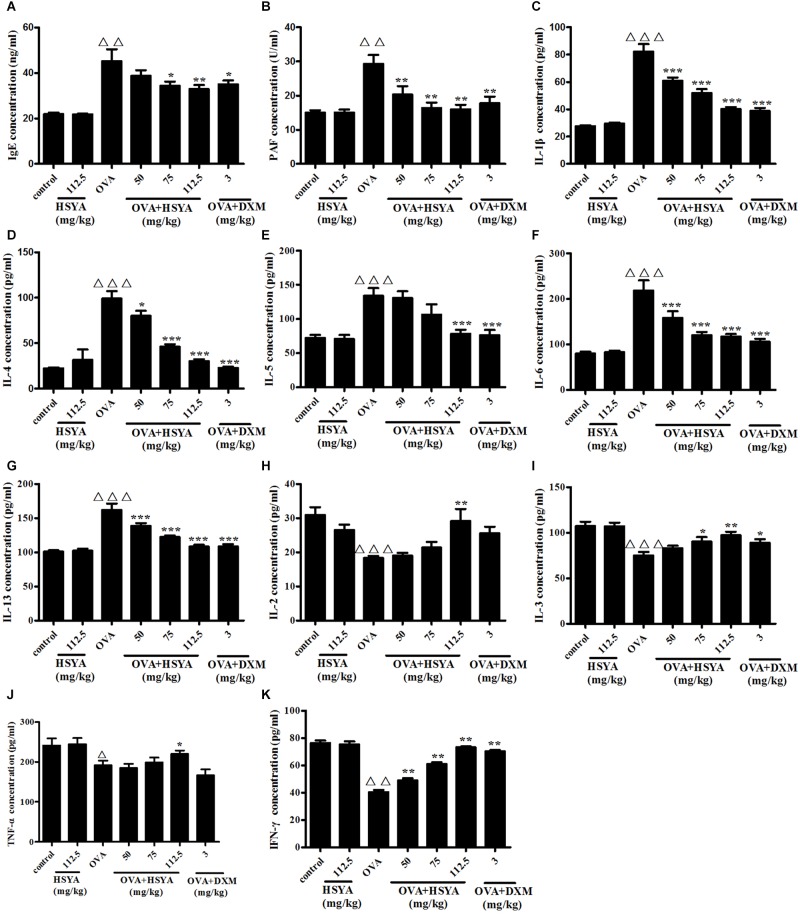
Effects of HSYA on plasma IgE (A), PAF (B), IL-1β (C), IL-4 (D), IL-5 (E), IL-6 (F), IL-13 (G), IL-2 (H), IL-3 (I), TNF-α (J), and IFN-γ (K) levels in guinea pigs. Data presented as mean ± SD. ∆∆
p < 0.01, ∆∆∆
p < 0.001 versus normal control group, ∗p < 0.05, ∗∗p < 0.01, ∗∗∗p < 0.001 versus OVA group.